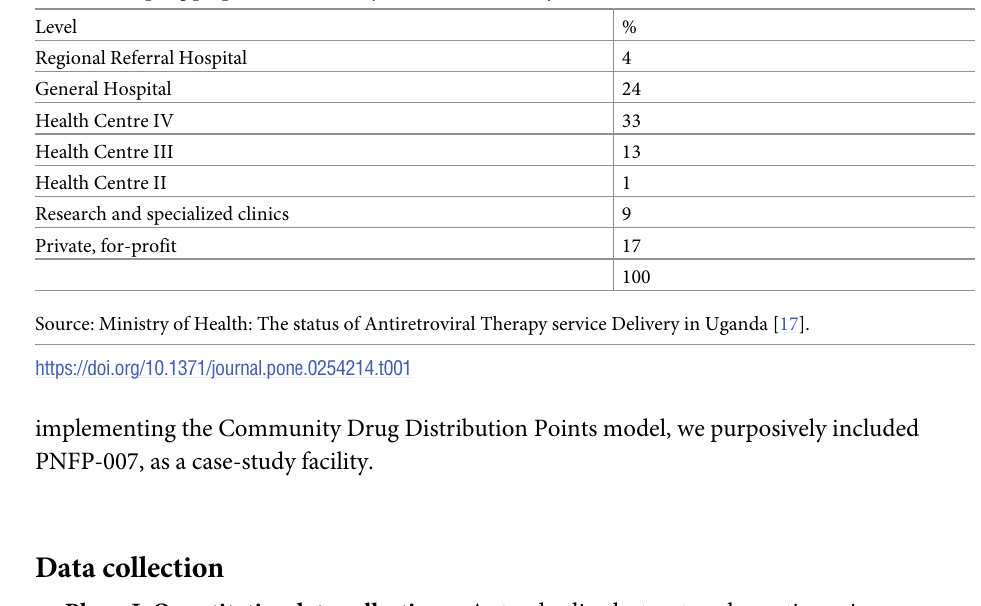
Table 1. Sampling proportional to size by ART service delivery